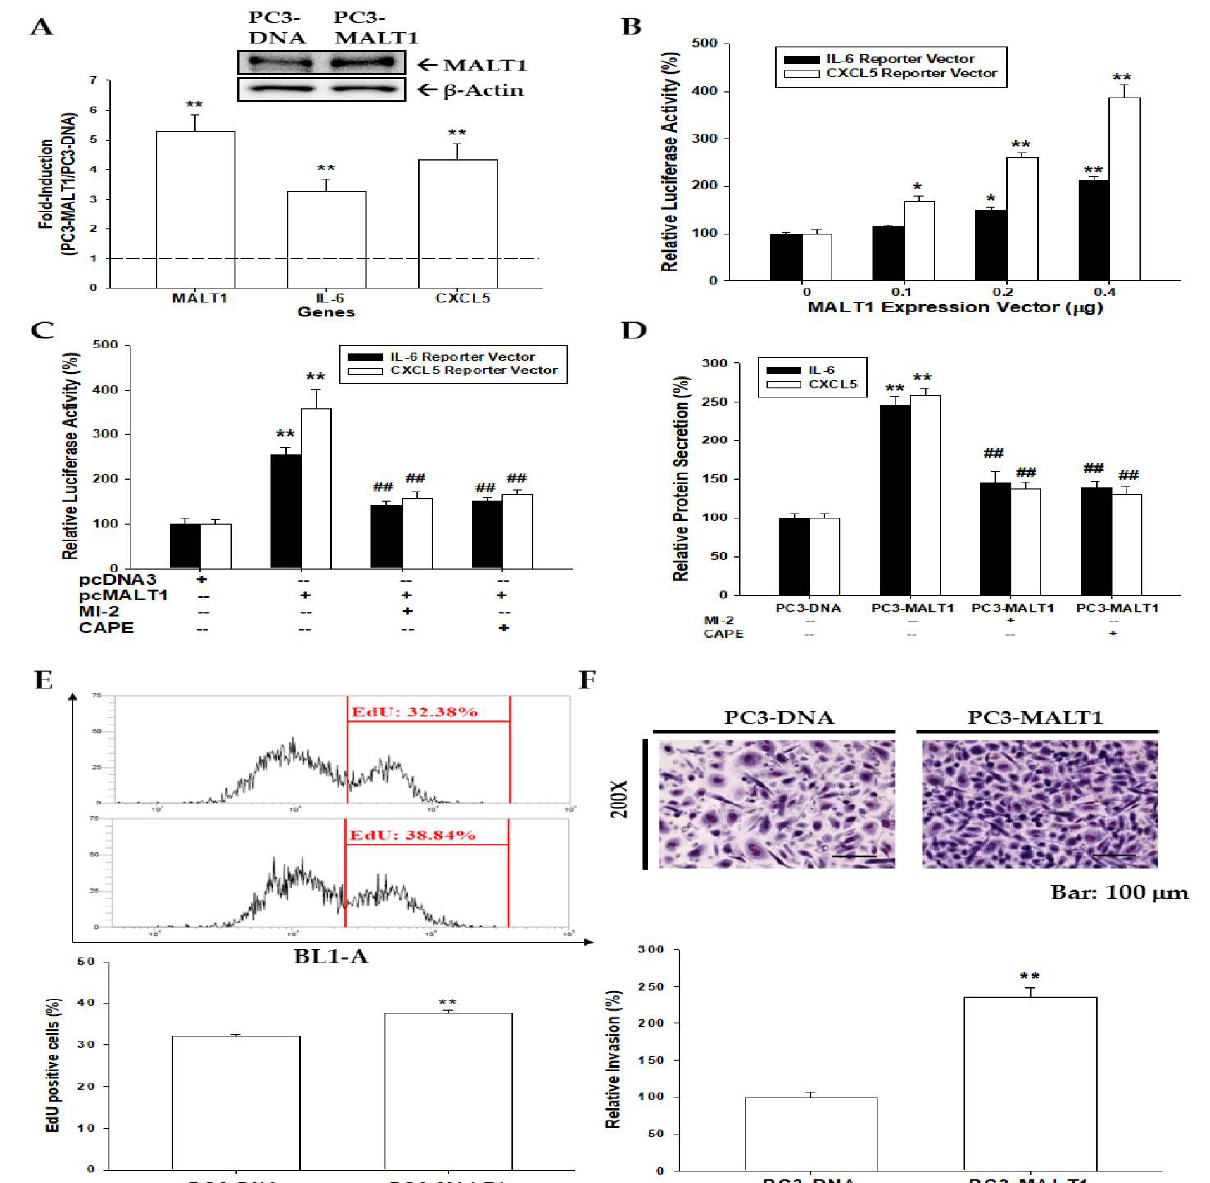
Figure 2. Effects of ectopic MALT1 overexpression on cell proliferation, cell invasion, and gene expression of IL-6 and CXCL5 in PC-3 cells. ( A ) Relative expressions of MALT1, IL-6, and CXCL5 after ectopic MALT1 overexpression in PC-3 cells were detected by immunoblot or RT-qPCR assays. ( B ) Relative luciferase activities of IL-6 and CXCL5 reporter vectors after cotransfection with various doses of MALT1 expression vectors. ( C ) The relative luciferase activities of IL-6 and CXCL5 reporter vectors after transient overexpression of MALT1 expression vector and treated with/without MI-2 and CAPE. Data are presented as mean percentage ± SE ( n = 6) of the luciferase activity in relation to the vehicle-treated group (* p < 0.05, ** p < 0.01), or relative to that of the MI-2 and CAPE-treated group (## p < 0.01). ( D ) Secretion of IL-6 and CXCL5 in MALT1-overexpressed PC-3 cells treated with/without MALT1 inhibitor, MI-2, a NF-κB inhibitor, CAPE. ( E ) The cell proliferation rate of PC3-DNA and PC3-MALT1 cells was measured by the EdU flow cytometry assay (± SE, n = 4; ** p < 0.01 ). ( F ) The effect of MALT1 overexpression on cell invasion in PC-3 cells was determined by the Matrigel invasion assay (bar: 100 µm), (± SE, n = 3; ** p < 0.01).